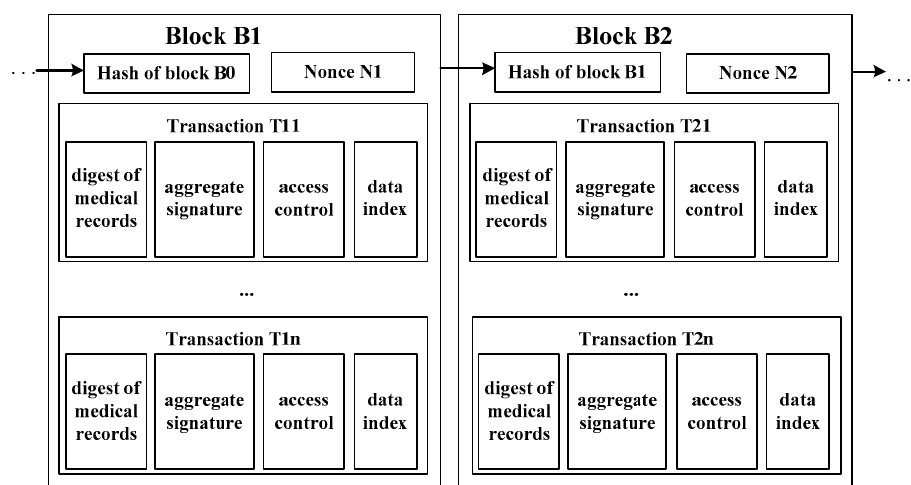
Figure 2. Medical Chain model .